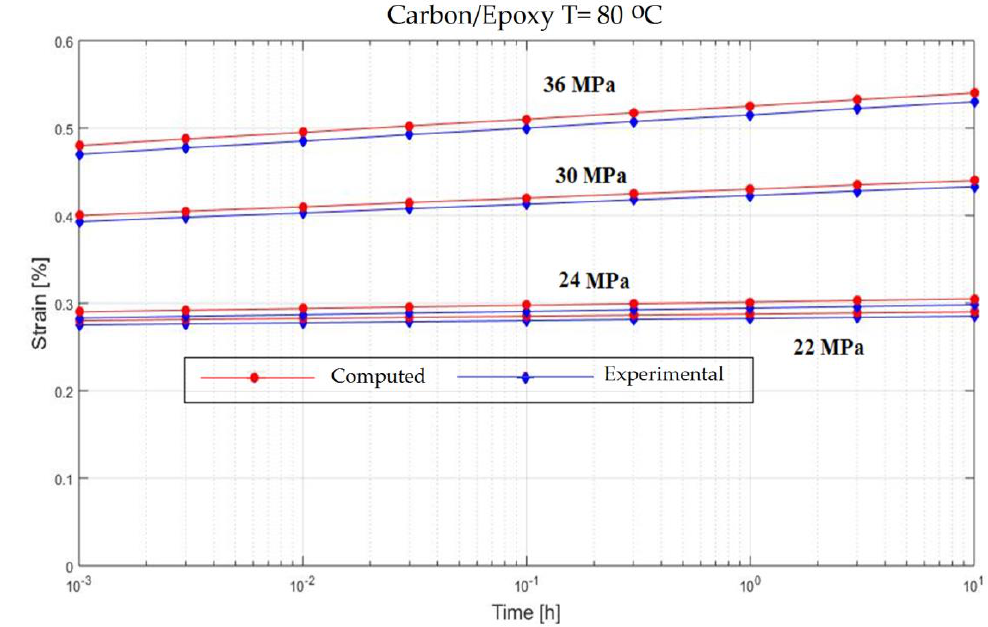
Figure 3. Creep response of a carbon/epoxy {90} 4s at T = 80 ° C.